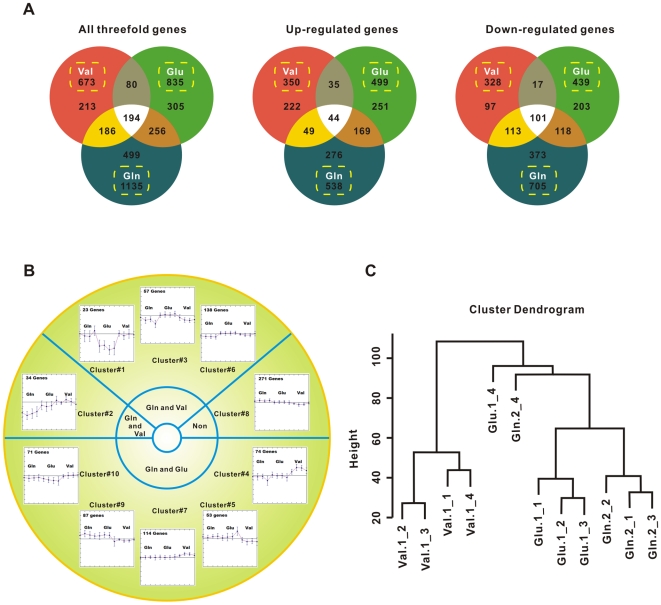
Amino Acid-responsive Genes.(A) Venn diagrams showing the overlap of genes that significantly changed after three amino acid pulses. The numbers represent a list of non-redundant genes with threefold induction or repression in response to valine (Val), glutamate (Glu), or glutamine (Gln). Numbers within boxes denote the total number of genes regulated by each amino acid. Some genes may be up-regulated at one time-point and down-regulated at another time-point. (B) Ten clusters and major functions of 922 between-experiment differentially expressed genes:Cluster #1, fatty acid β-oxidation (YsiA-regulon); Cluster #2, fatty acid biosynthesis (YlpC-regulon, des); Nitrogen metabolism (nasABC/nrgAB operon, glnA); sporulation (kipAI); transcriptional factor (GlnR, TnrA, KipR, PucR); LexA-regulated genes; Cluster #3, glutamine ABC transporter (glnQHMP); arg operon; sporulation and germination, Phage-related genes (PBSX prophage); Cluster #4, fatty acid biosynthesis (YlpC-regulon, bkd operon); bir operon; Cluster #5, PhoP-regulated genes; Mobility and chemotaxis, arg operon genes; capsular polysaccharide biosynthesis (yve operon); Cluster #6, amino acid ABC transporter genes; Phage-related genes (PBSX prophage); Specific pathways; sporulation and germination; Cluster #7, Cell wall; Fur-regulon genes; Cluster #8, Transport/binding proteins and lipoproteins; Membrane bioenergetics; Specific pathways; Metabolism of coenzymes and prosthetic groups; Phage-related functions; Cluster #9, Biosynthesis of teichuronic acid (tua operon); glutamine and BCAA ABC transporter; Cluster #10, oligopeptide ABC transporter (opp operon); surfactin synthetase srf operon. (C) Relationships among the Val, Glu, and Gln treatments:The dendrogram was calculated by hierarchical clustering using data on the expression of all Val-, Glu-, or Gln-regulated genes. The dendrogram represents the similarity of the gene expression profiles with the Val, Glu, and Gln treatments at each time point.